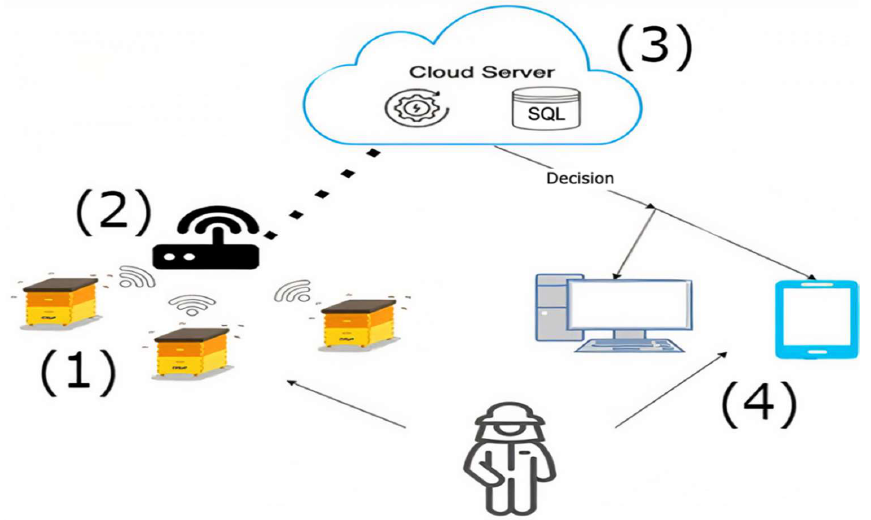
Figure 1. BeeSD system high-level system architecture.